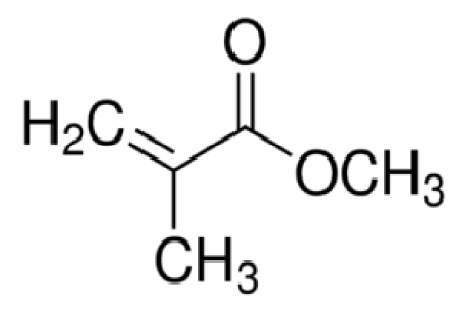
Figure 1. Methyl methacrylate (MMA) monomer.